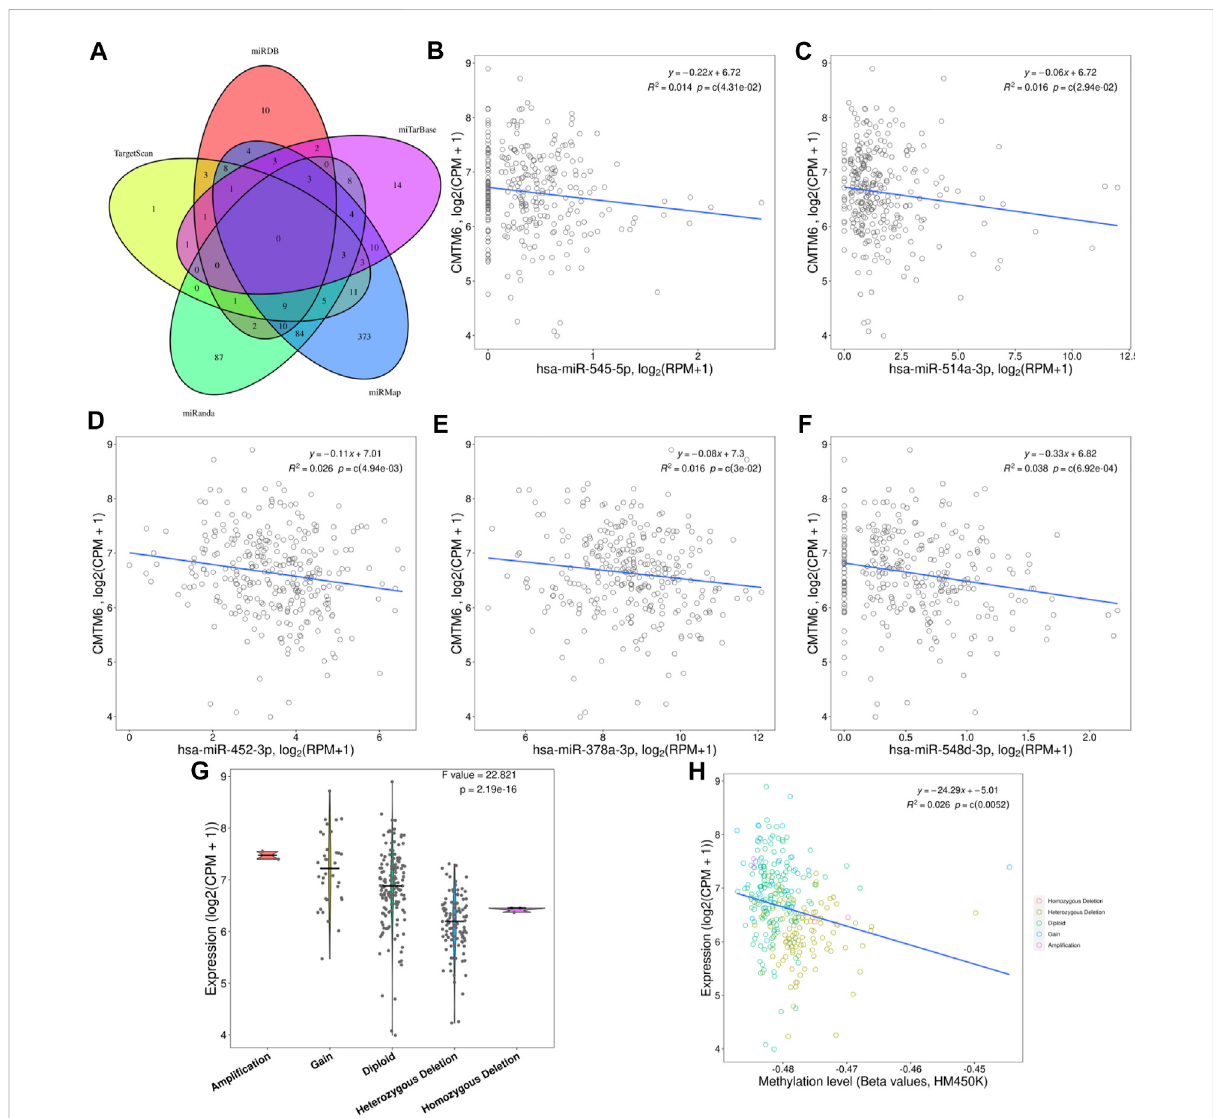
FIGURE 8 CMTM6-related upstream mechanisms. (A) Five online tools were used to predict miRNAs that target CMTM6. The correlations between CMTM6 and has-miR-545-5p (B) , has-miR-514a-3p (C) , has-miR-452-3p (D) , has-miR-378a-3p (E) , has-miR-548d-3p (F) in CC were analyzed. Copy number change (G) and methylation level (H) of CMTM6 is associated with mRNA